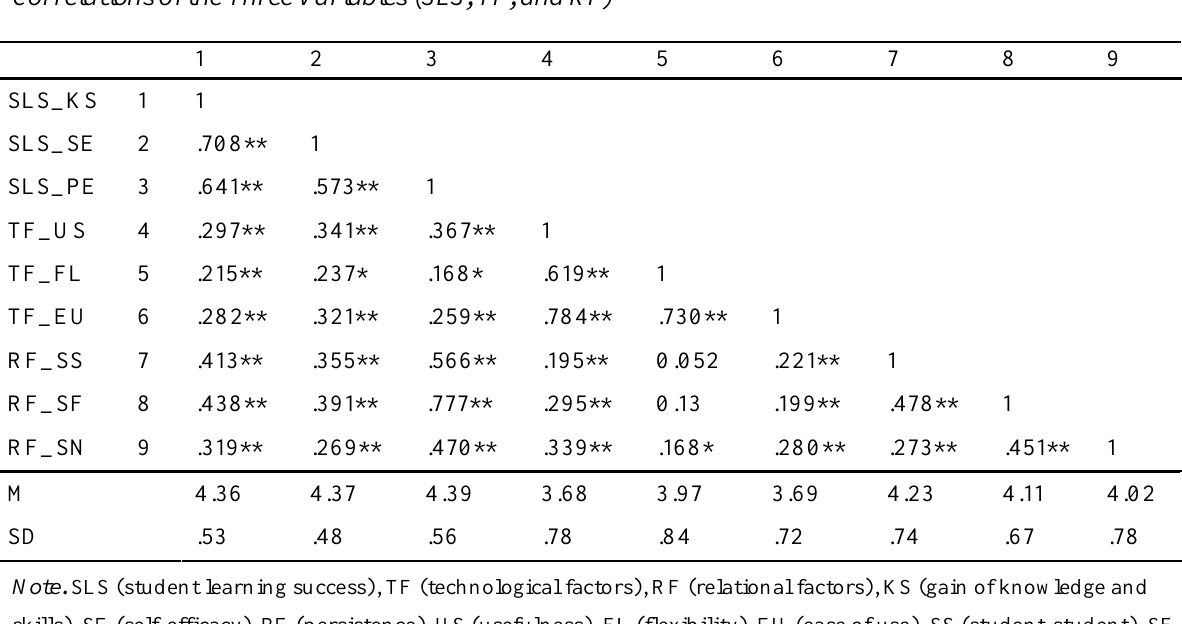
Correlations of the Three Variables (SLS, TF, and